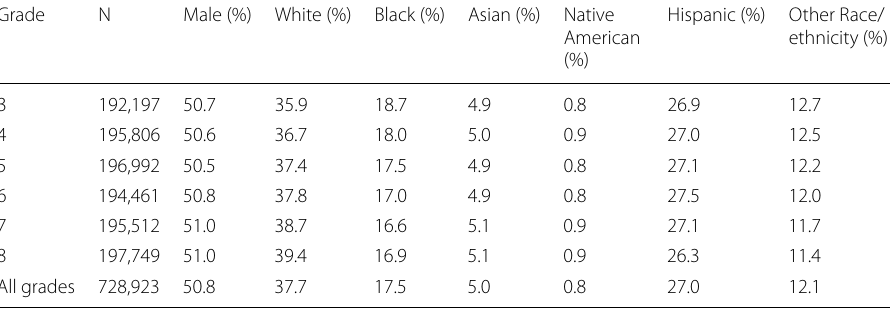
Table 2 Descriptive characteristics of the